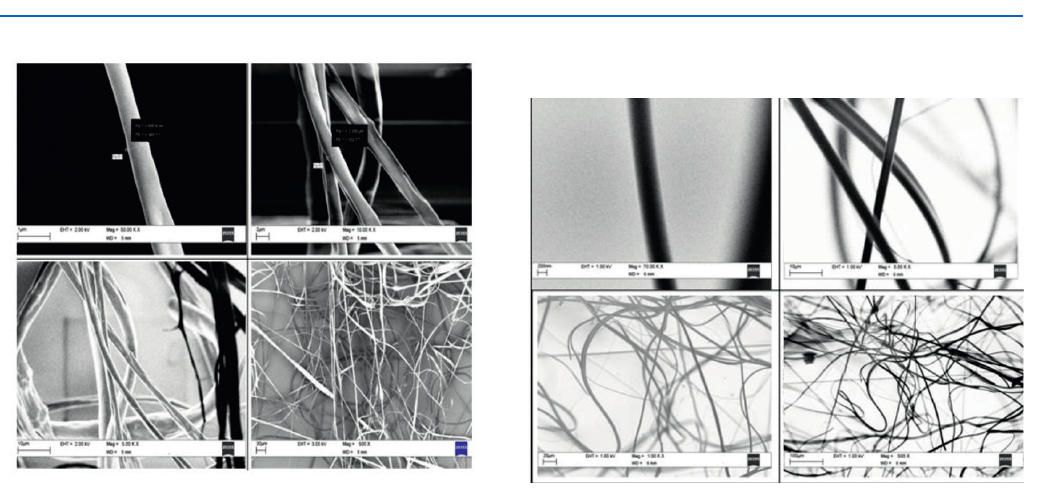
Fig. 7. SEM image of 15% PVP: 10% TiO nanofibers